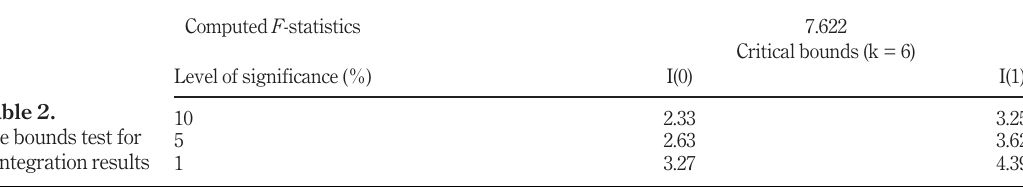
Table 2. The bounds test for cointegration results